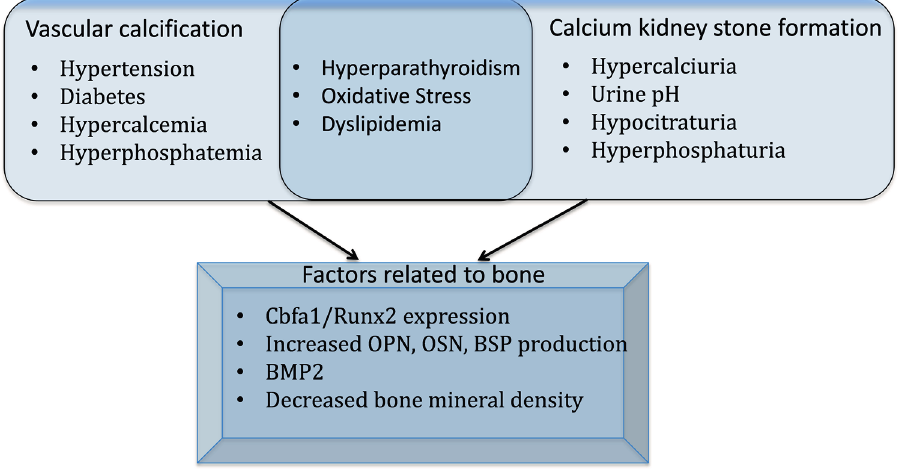
Figure 2. Identified instigators of vascular calcification and stone formation,